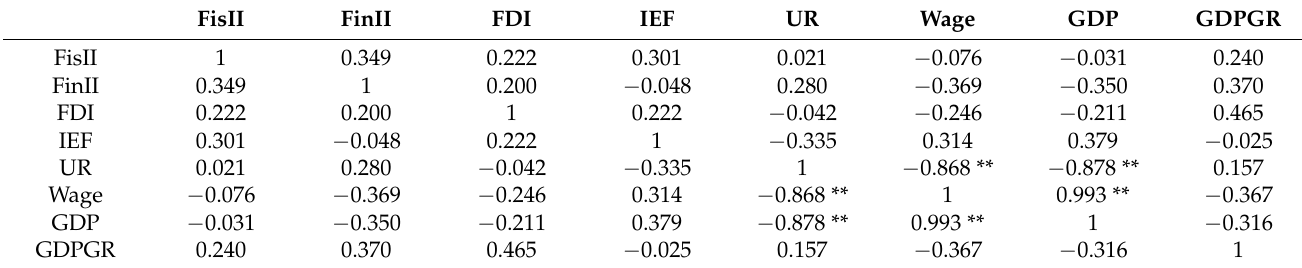
Table 2. Correlation